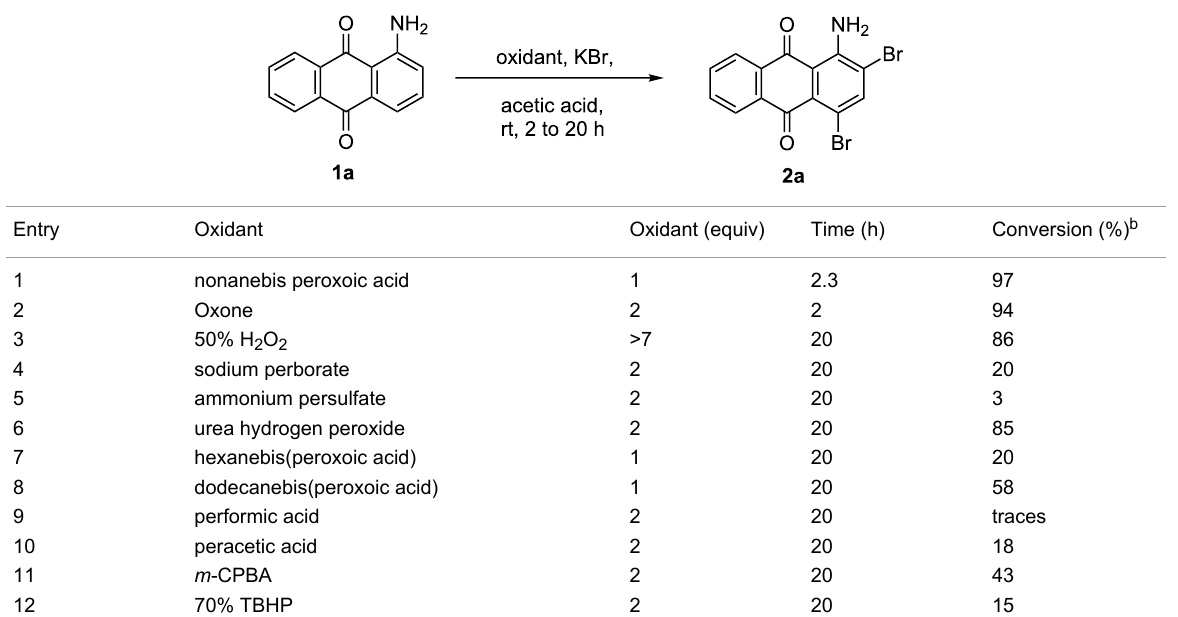
Table 3: Comparison with commercially available oxidants. a